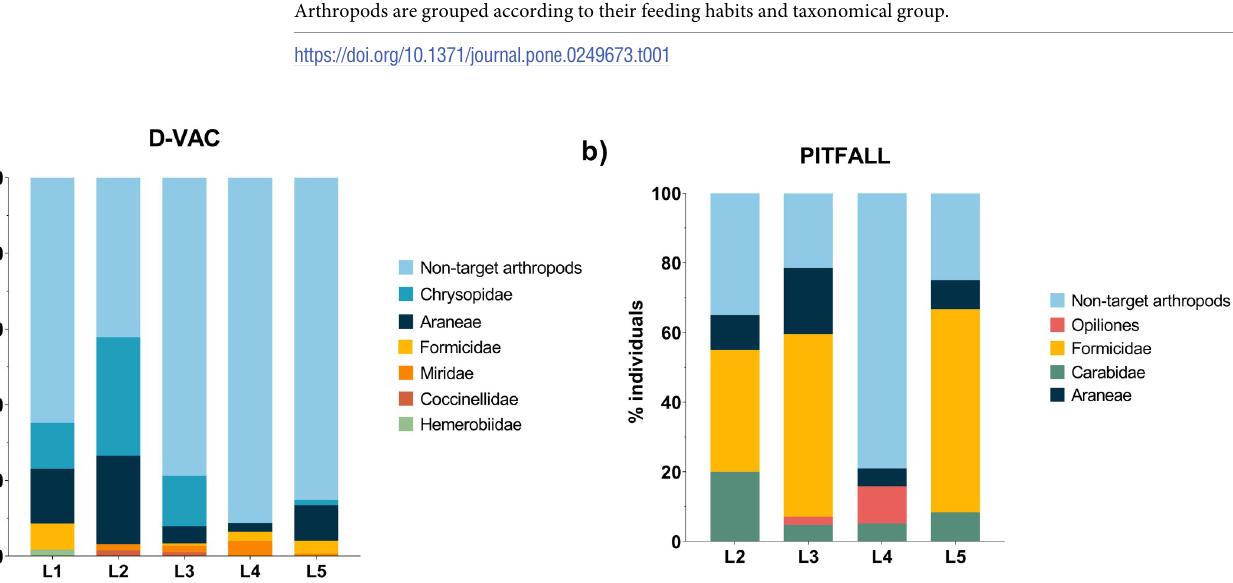
Fig 3. Arthropod diversity collected on berry fields. a) D-Vac collected arthropods; b) Pitfall traps collected arthropods. Values are presented as percentage of individuals from each taxonomical group collected in each location.